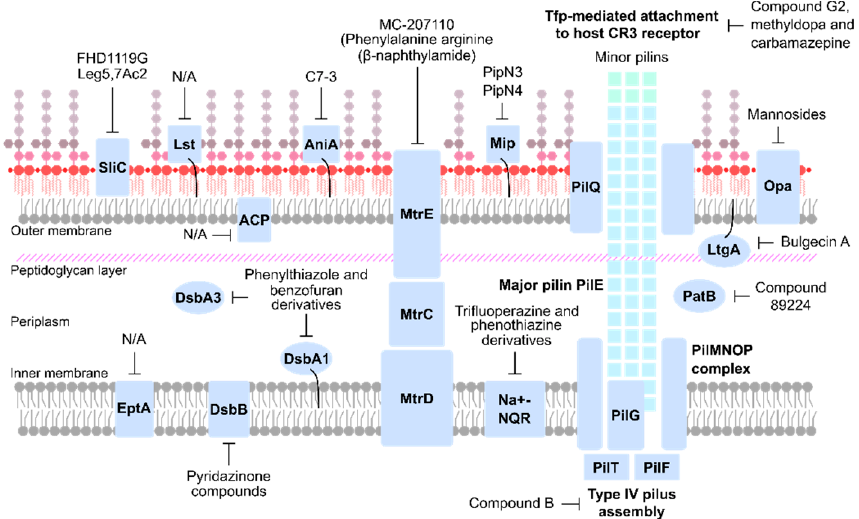
Figure 2. Overview of anti-virulence therapeutic targets of N. gonorrhoeae .